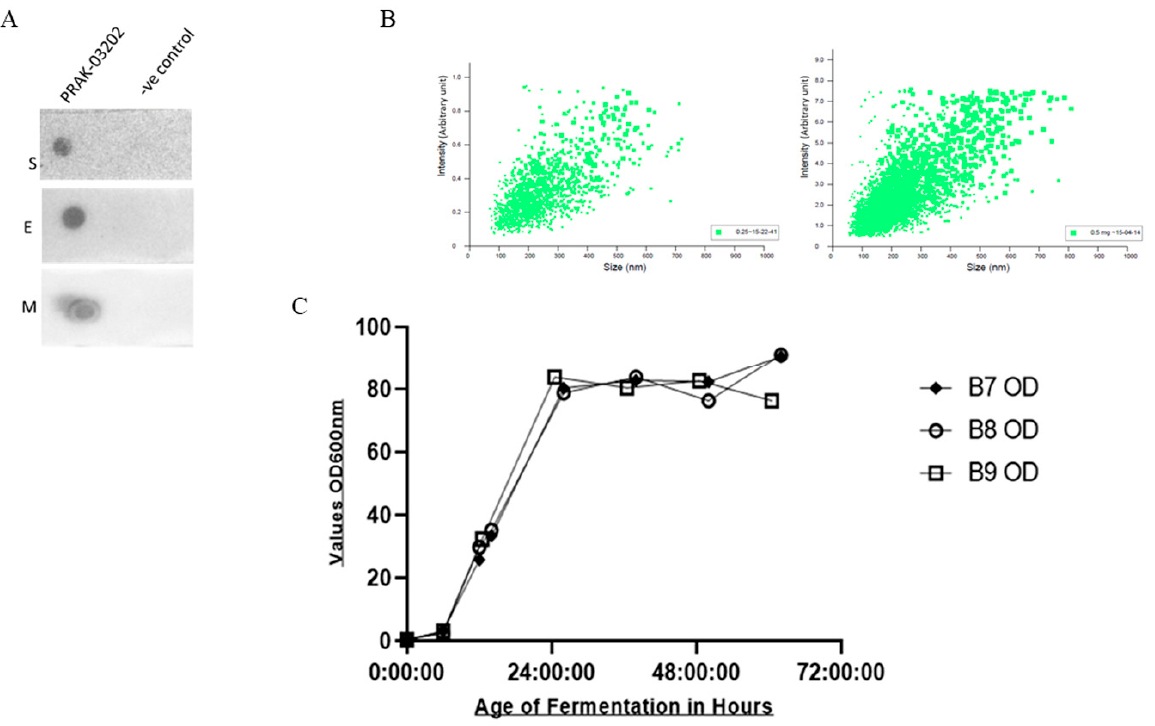
Figure 1. ( A ) Dot blot analysis for co-expression of spike, envelope, and membrane proteins in the S. cerevisiae -based D-Crypt™ platform using antigen-specific antibodies S: spike protein, E: envelope protein, M: membrane protein. ( B ) Nanoparticle tracking analysis with 0.25 (left panel) and 0.5 mg (right panel) of PRAK-03202. ( C ) Optimum time to obtain maximum production of PRAK-03202 in the fermenter. The fermenter was harvested at 24, 48, and 72 h to determine the maximum OD of the